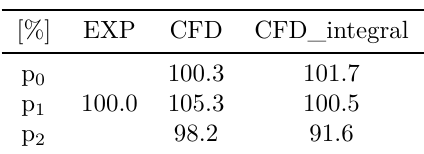
Table 1. Comparison of static pressures in individual planes.